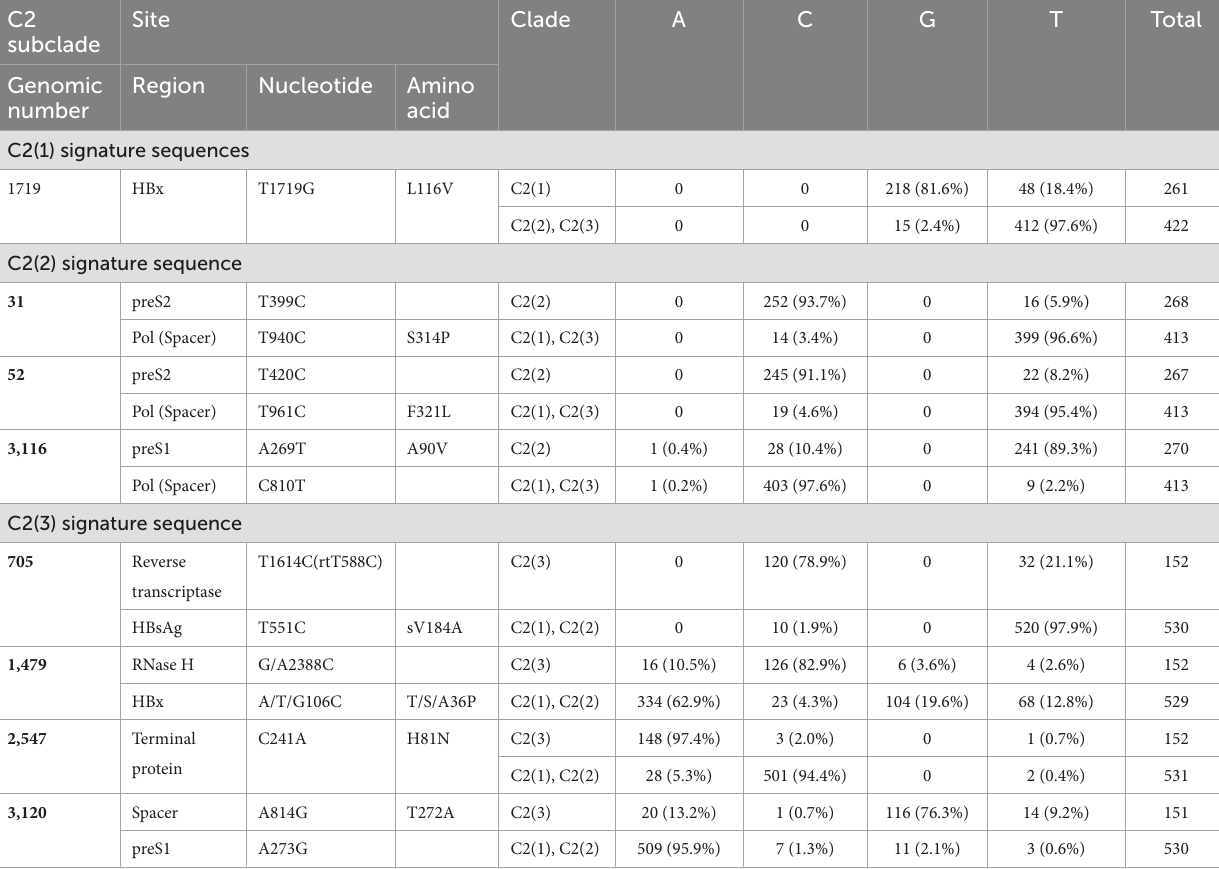
TABLE 2 Nonsynonymous mutation sites and their incidence rate in each clade of subgenotype